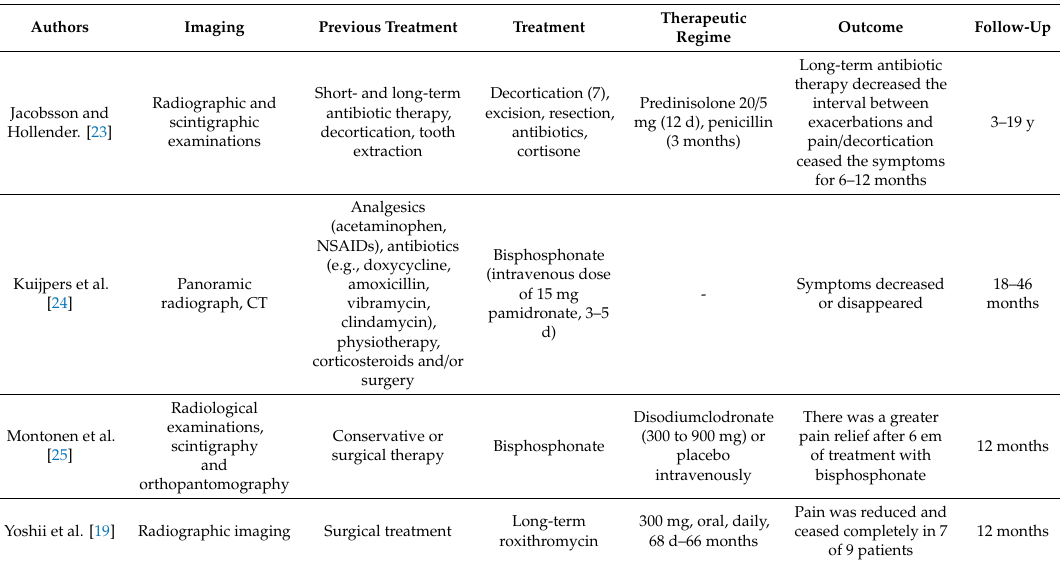
Table 3. Treatment protocol of the included